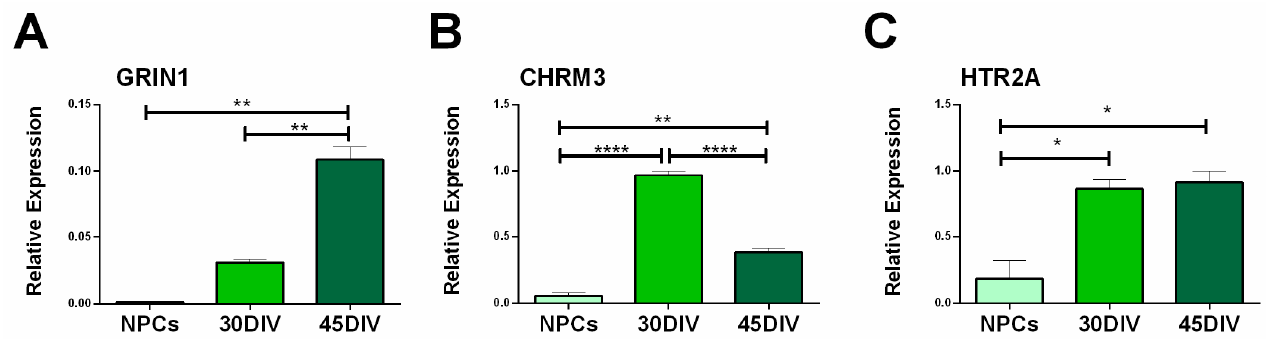
Figure 4. Expression of N-methyl-D-aspartate (NMDA) receptor, Muscarinic acetylcholine receptor (mAChR) and 5-Hydroxytryptamine receptor (5HTR) in NPC and hiPSC-derived neurons. Bar graphs showing RT-qPCR results for Glutamate Ionotropic Receptor NMDA Type Subunit 1 (Grin1; ( A )), Cholinergic Receptor Muscarinic 3 (Chrm3; ( B )), and 5-Hydroxytryptamine Receptor 2A (Htr2a; ( C )) at 30 and 45 DIV. All receptors showed upregulation in hiPSC-derived neurons compared to NPCs. Histogram bars represent the mean values ± SEM of relative expression, at least n = 3 replicated for each group. * p < 0.05, ** p < 0.01, **** p < 0.0001, by one way ANOVA, Bonferroni’s multiple comparisons.